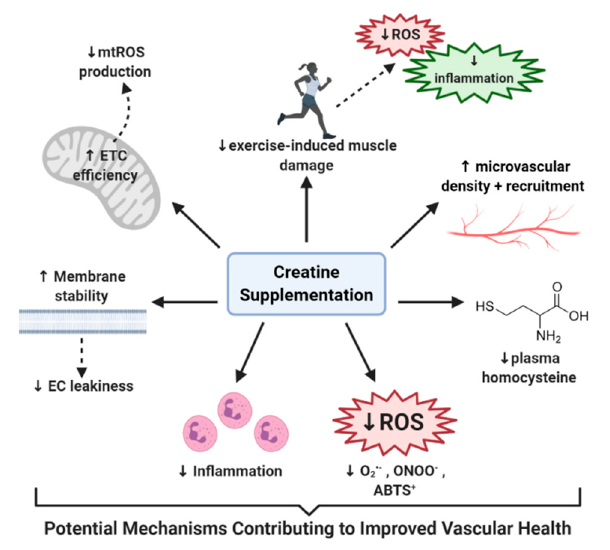
Figure 2. Potential mechanisms contributing to improved vascular health: ROS = reactive oxygen species, ABTS + = 2,2’-azino-bis3-ethylbenzothiazoline-6-sulphonic acid, ETC = electron transport chain, mtROS = mitochondrial specific ROS, EC = endothelial cell, O 2 − = superoxide, ONOO − =